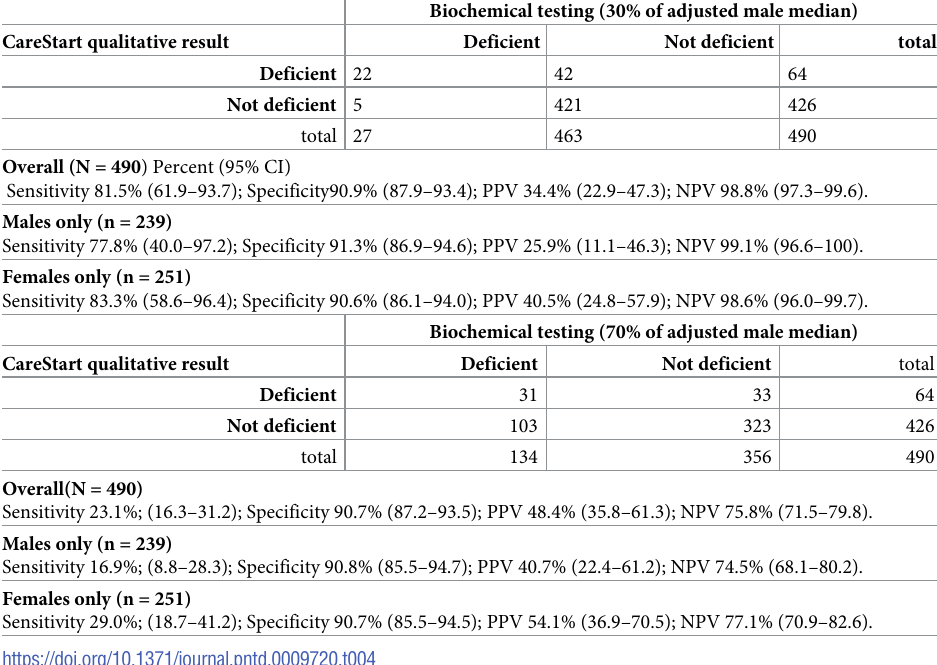
gene polymorphisms across both study sites, all persons tested were GG homozygotes (100% GG genotype frequency). For G6PD A376G, the following genotypes were detected: AA (n = 235; 100%) in New Halfa; AA (n = 147; 90.7%), GG (n = 11; 6.8%), AG (n = 4; 2.5%) in Khartoum (Table 5). Among the females examined in New Halfa (n = 122), the G6PD A376G genotype was entirely AA (100%), whereas the distribution in Khartoum (n = 90) was AA (n = 81; 90%); GG (n = 5; 5.6%); AG (n = 4; 4.4%) (Table 5); there was a statistically significant difference in the distribution of A376G polymorphisms by geographic location (p < 0.001; χ 2 test). Of these participants with non-wild-types, the associated G6PD enzyme activities are shown in Fig 5. In analysis of the 27 G6PD deficient subjects, 26 carried B variants, and one homozygous female carried an A variant. In this population, the A- variant was not detected; however, the Mediterranean variant was not tested for in this study. The genotype of all 27 G6PD deficient subjects was AA for the G202A polymorphism. For the A376G polymorphism, 26 subjects had the AA genotype while one subject carried the GG genotype.